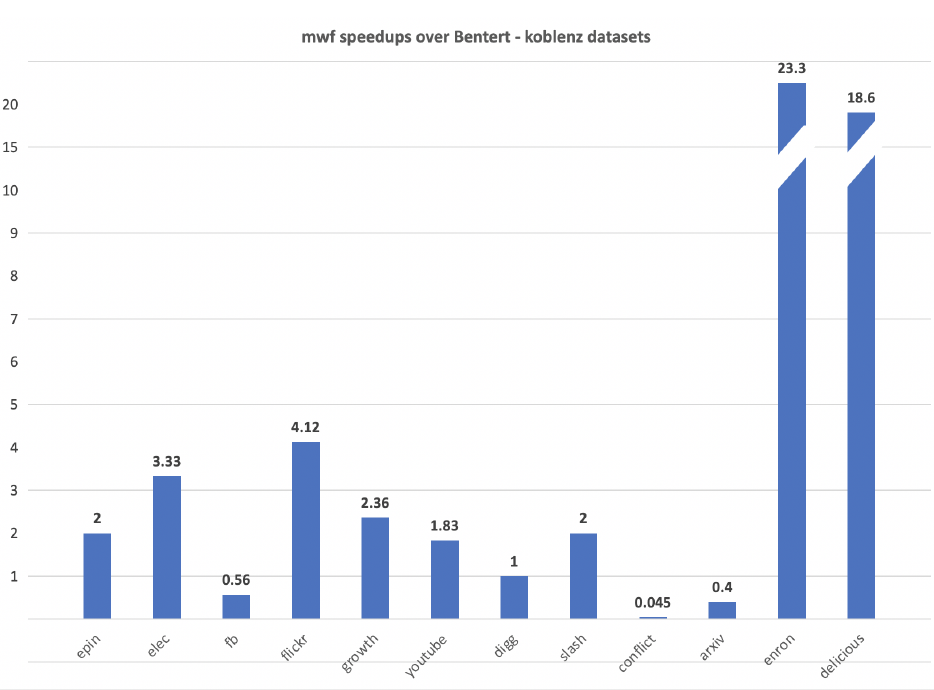
Figure 14. mhf speedups on synthetic datasets.